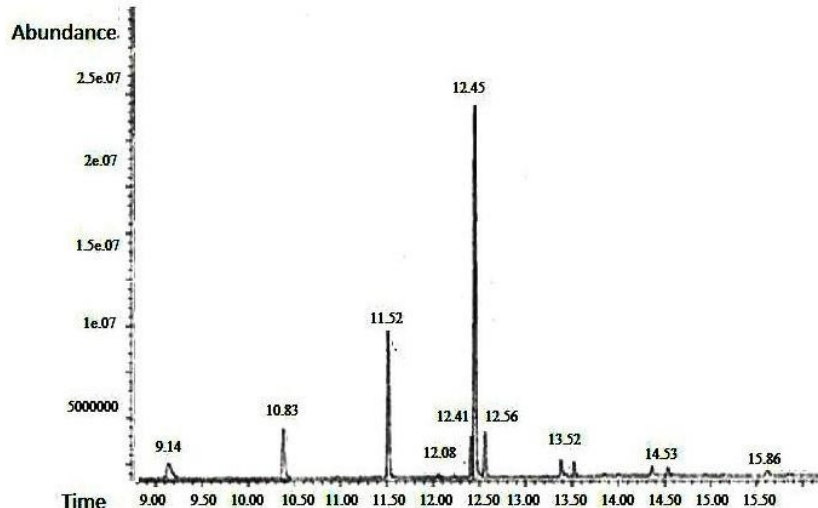
Figure 4. GCMS of the methyl ester fatty acid. Table 1. GCMS for the gorse flower fatty acids.